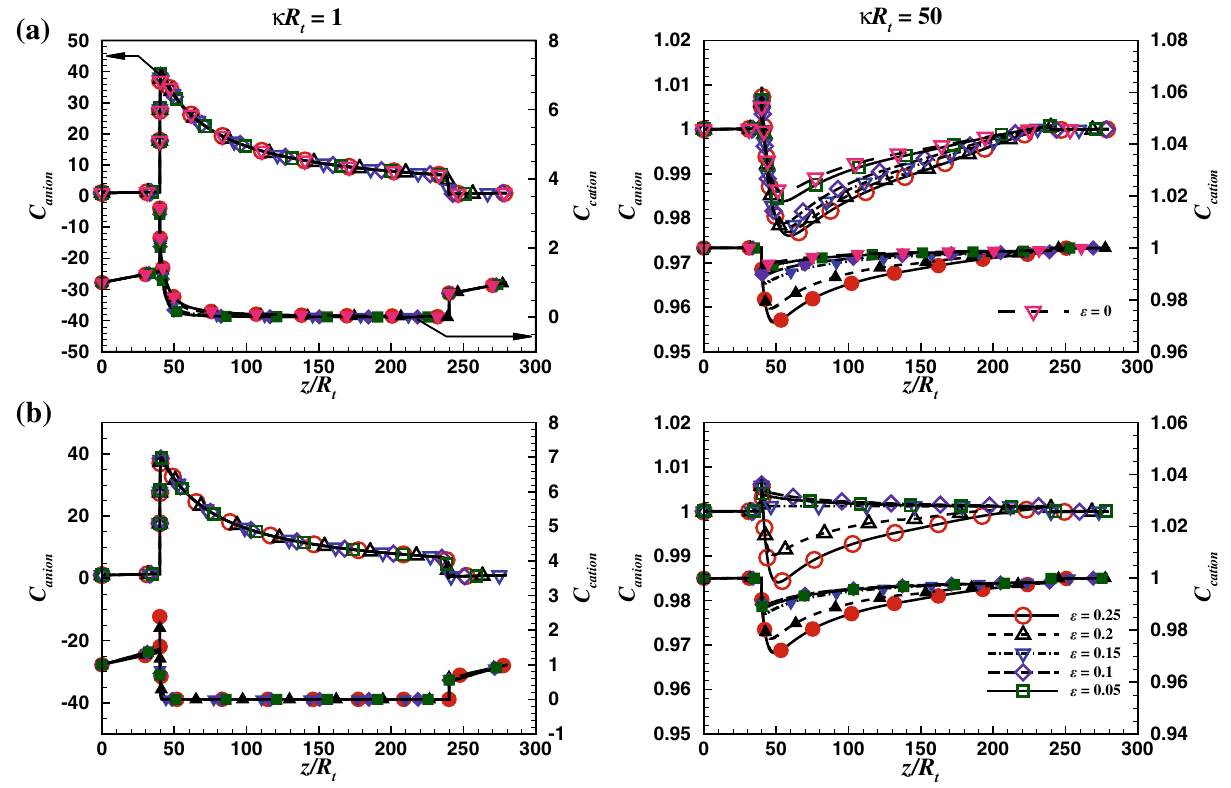
Figure 9. Axial average concentration variation of anion (empty symbols) and cation (filled symbols) with scores of values of ε including the Newtonian fluids, for V = 40 , σ = − 50 and two extreme values of κ R t ( a ) De = 1 and ( b ) De = 100